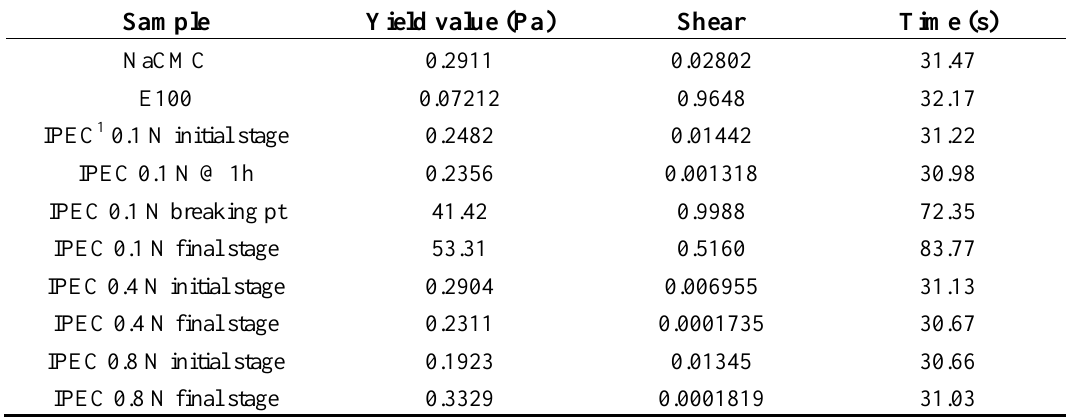
Table 1. Yield values of native polymers and IPEC at the sampling stages during synthesis.